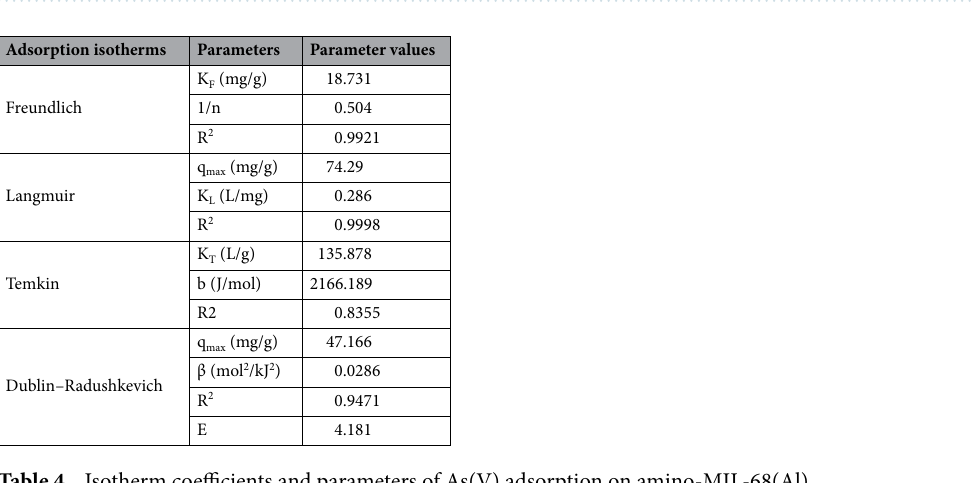
Figure 8. Nonlinear isotherm models (pH = 3) ( a ), and nonlinear adsorption kinetic models (pH = 3, As(V) = 50 mg/L) ( b ) for As(V) adsorption on amino-MIL-68(Al).